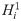
Figures show the construction of node potentials for the detection of the inner bowel wall.All figures are displayed in radial coordinates, with the distance from origin shown in the vertical axis, and the angle of rotation in the horizontal axis. The original image is shown top left. Top middle shows the gradient node potentials Hi1. Top right shows the cumulative node potentials Hi2. Bottom left shows the combined node potentials Vi. Bottom right shows the belief vectors bj. All measures are scale invariant.